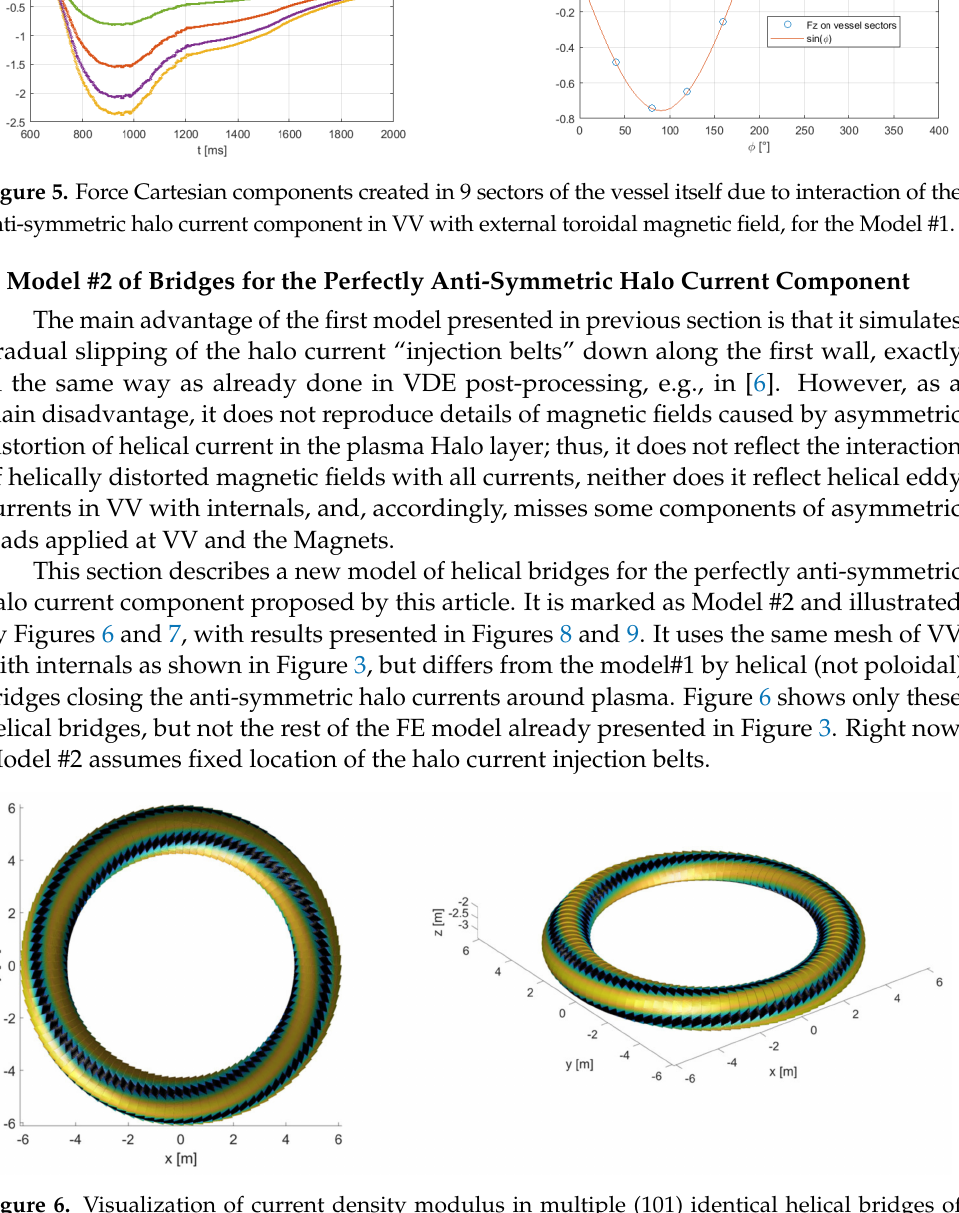
Figure 6. Visualization of current density modulus in multiple (101) identical helical bridges of Model #2, built to match approximately kink mode m = 1, n = 1 (Color code represents not direction but modulus of the current density when the bridges are fed by harmonically distributed anti- symmetric halo currents). The remaining parts of FE model are in Figure